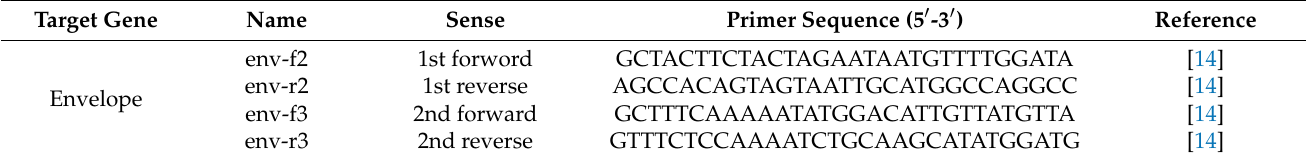
Table 1. Primer used in nested-PCR amplification. The expected amplicon size after the second PCR is 600